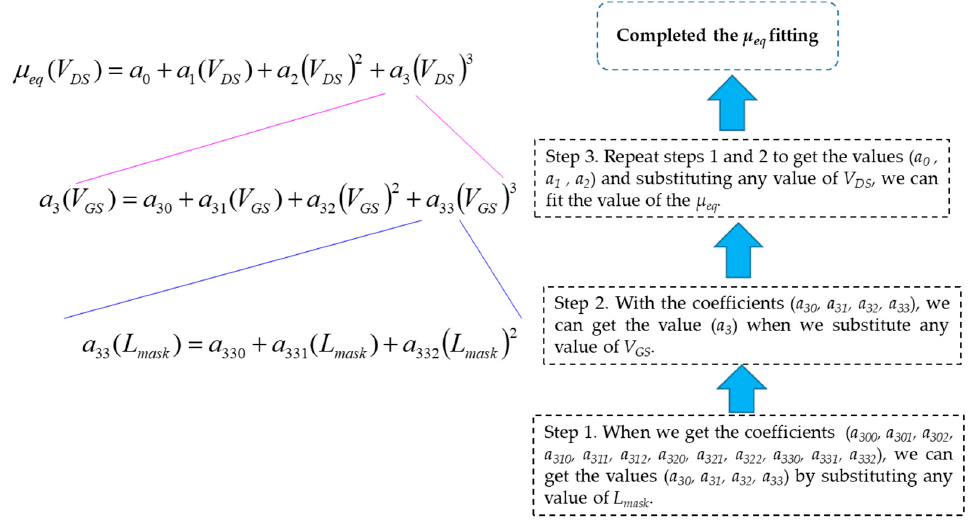
Figure 6. Fitting the coefficients of μ eq in section X = a as an example. On the left-hand side, the expansion relationship between a 3 and a 33 is illustrated.